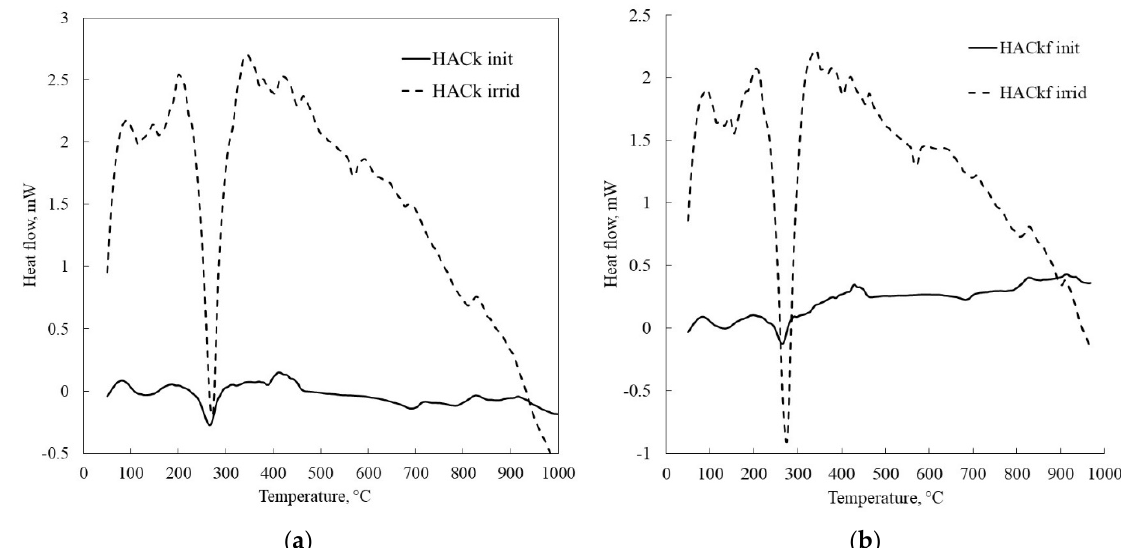
Figure 18. Thermograms of initial and irradiated HACk ( a ) and HACkf ( b ) concretes. Table 4. Thermal e ff ects and mass losses during heating of HACk and HACkf concretes.